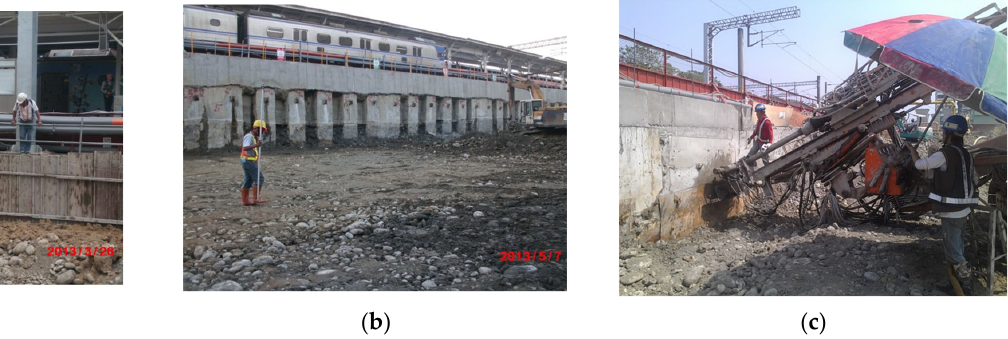
Figure 3. Construction photos of this project: ( a ) concrete pouring work for the vertical wall; ( b ) completed retaining piles and tie ‐ beams; ( c ) ground anchor.